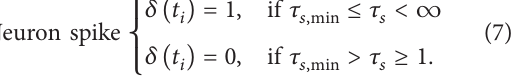
𝑓 = 0 ms and 𝑡 𝑓 = 7 1 2